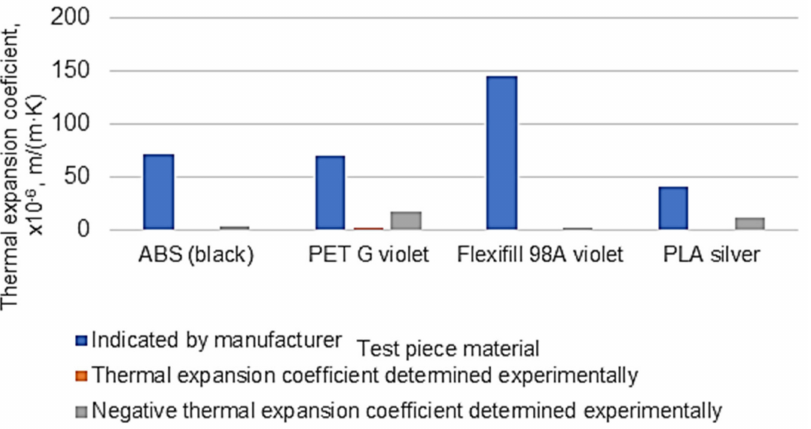
Figure 8. Highlighting the differences between the values of the coefficients of linear thermal expansion indicated by the material manufacturers or identified in specialized documents [20,21] and the values obtained in case of thermal expansion of the spiral test